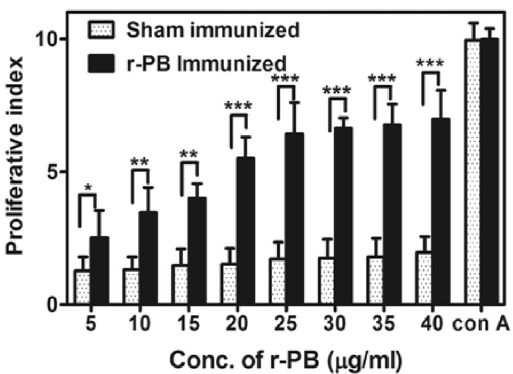
Figure 4. Lymphocyte proliferation assay. Proliferation of r-PB and sham immunized mice splenocytes re- stimulated with gradient concentrations of r-PB determined by MTT assay. Conconavalin A at 20 μ g was used as positive control. Experiments were performed in triplicates and data represented as mean PI values ±